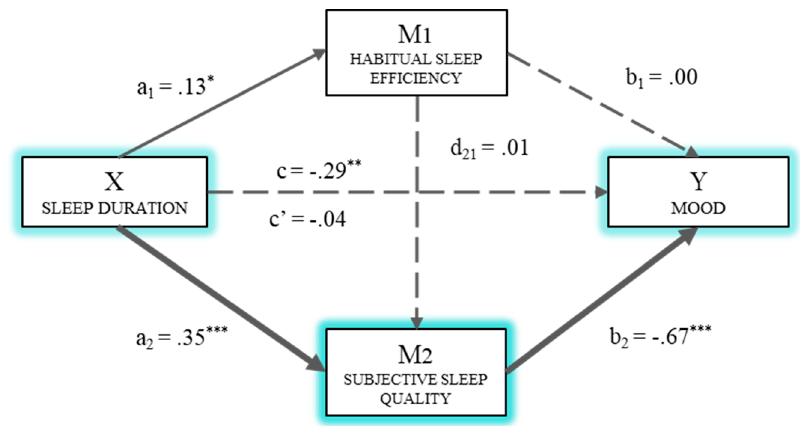
Figure 2. Multiple mediation model of sleep efficiency and subjective quality on the relationship between sleep duration and stress management. * p < 0.05; ** p < 0.01; *** p < 0.001.